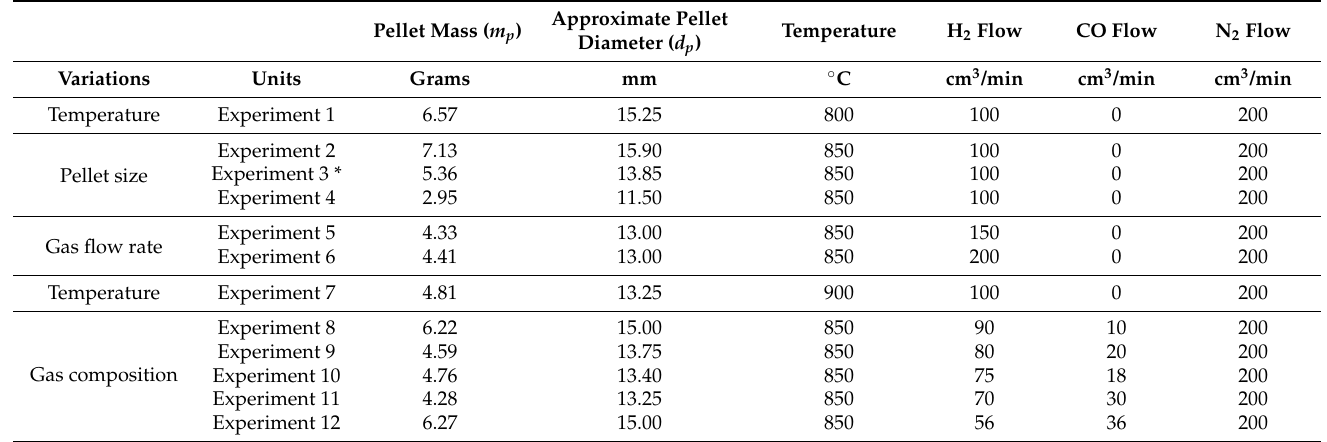
Table 1. Parameters of iron ore pellet reduction